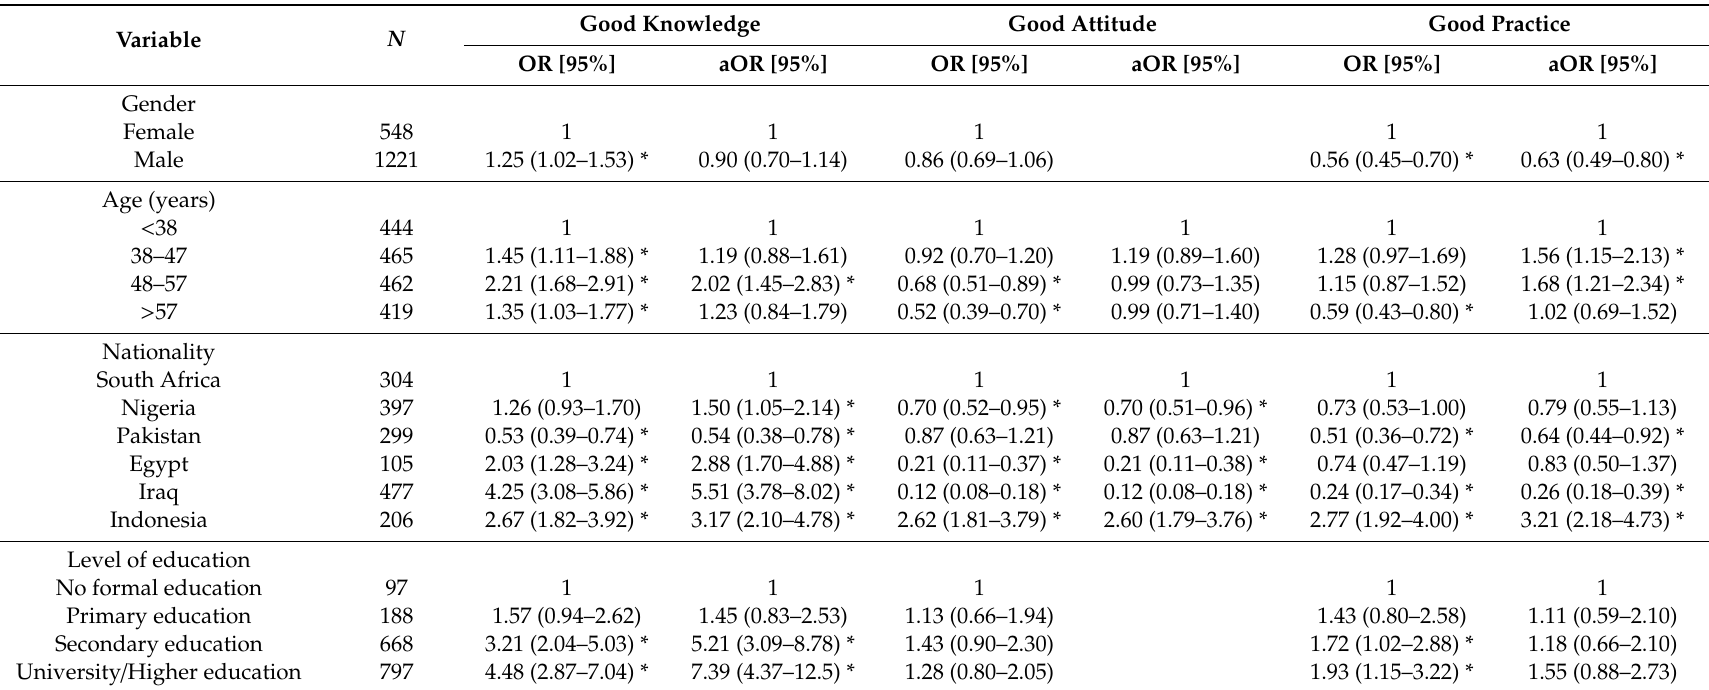
Table 4. Association between variables and good knowledge, attitude and